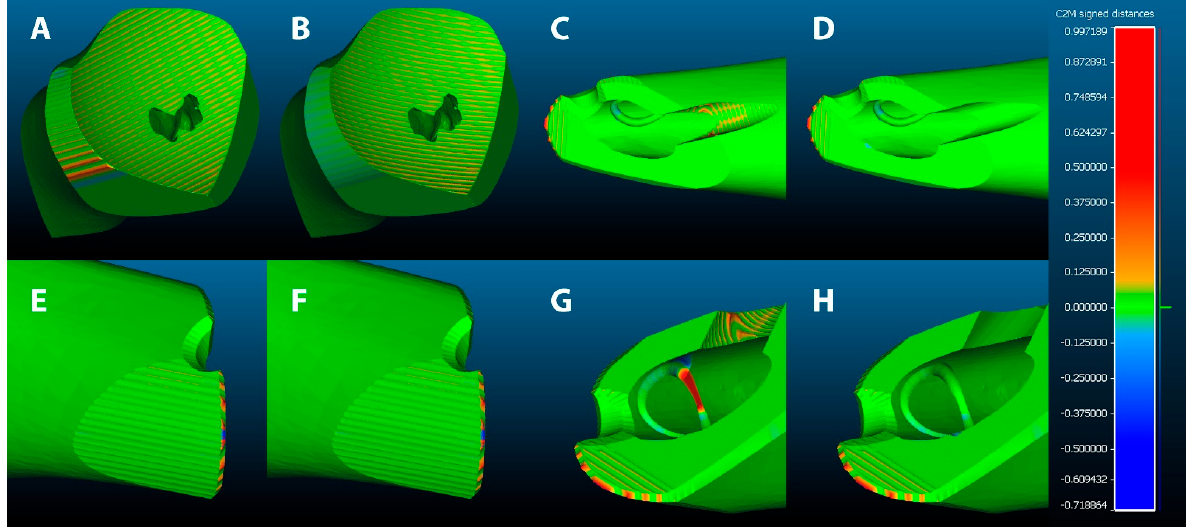
Figure 4. CloudCompare analysis. ( A , C , E , G ) Four-axes simulation. ( B , D , F , H ) Robot simulation. Custom scalar fi eld: red at +1 mm; orange at +0.1 mm; green at 0 mm; light blue at − 0.1 mm; blue at − 1 mm.